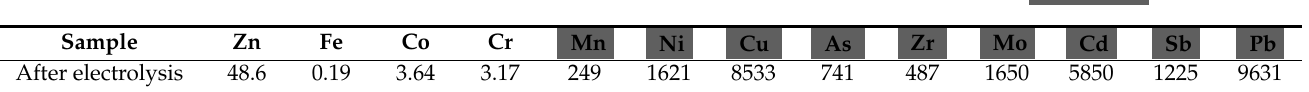
Table 10. ED-XRF analysis of the cathode mass after the electrolysis (input sludge—B21 supplier). (wt.% Zn, Fe, Cr, Co; wt. ppm, Mn, Ni, Cu, As, Zr, Mo, Cd, Sb and Pb— grey color ).